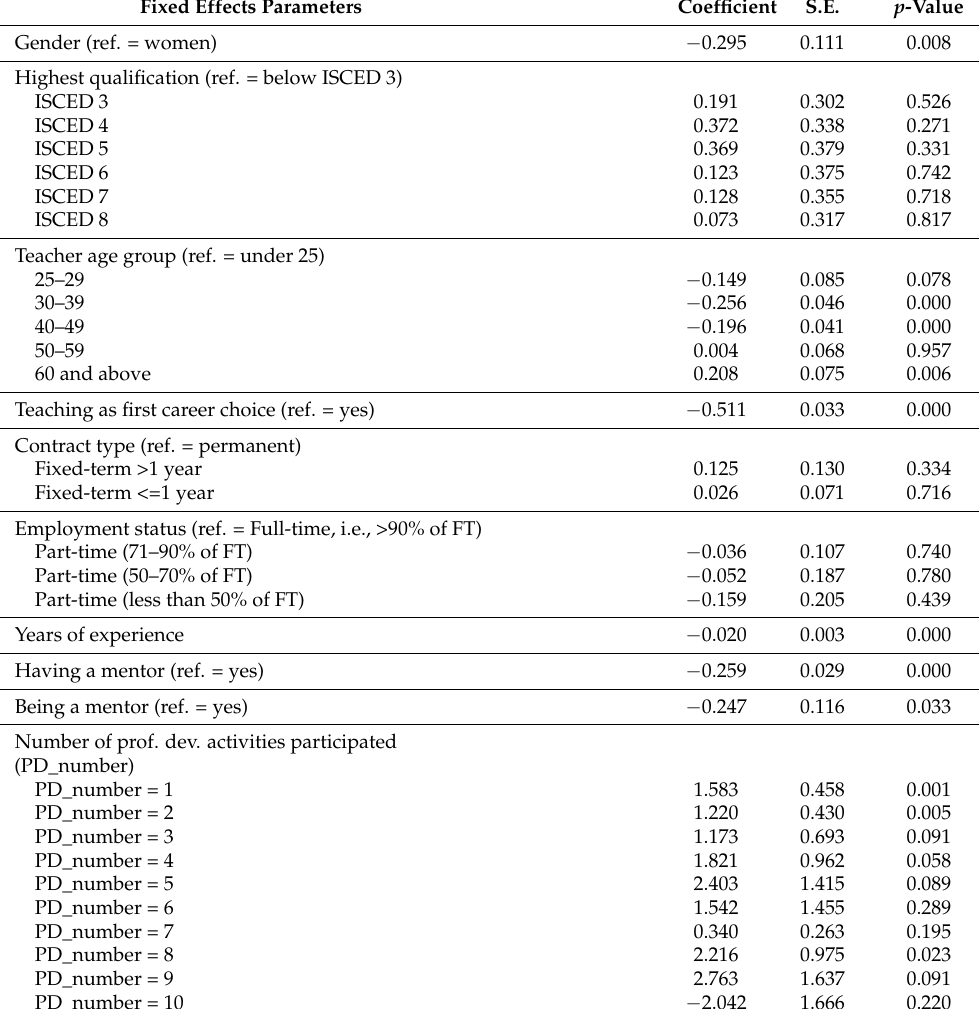
Table A1. Estimation results from multilevel model with PD_number included as dummy